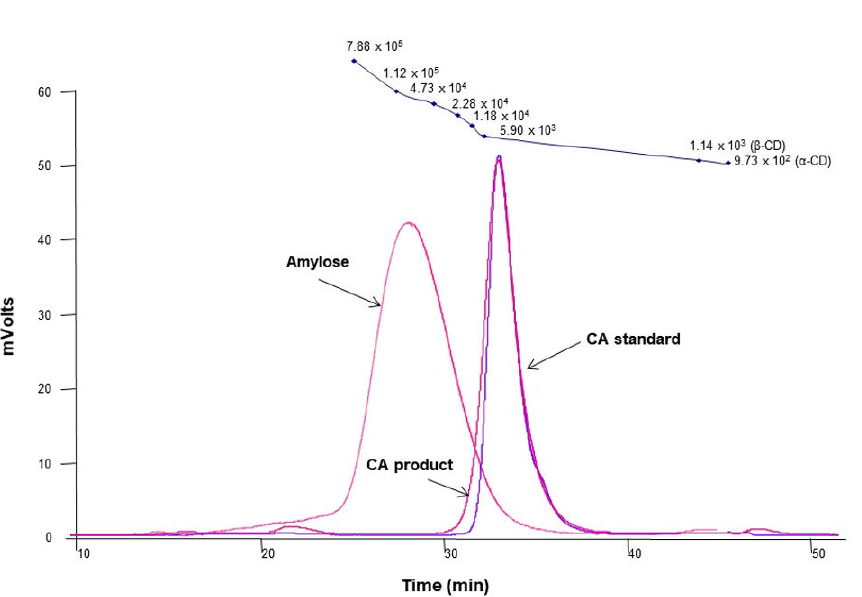
Figure 1. The molecular weight distribution of amylose, cycloamylose (CA) standard, and the CA product. At the top of the graph, the molecular weight values measured with pullulan standard, α - and β -cyclodextrin (CD) were